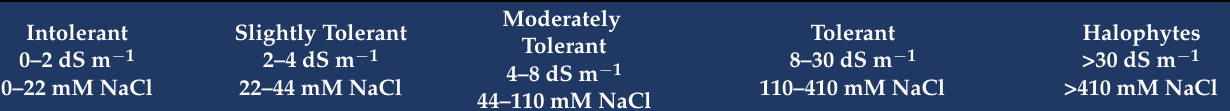
Table 2. Relative salinity tolerance among turfgrass species and their hybrids with estimated cultivar variations within each species (within the same category of the same background color, the order is following the scientific name in alphabetical